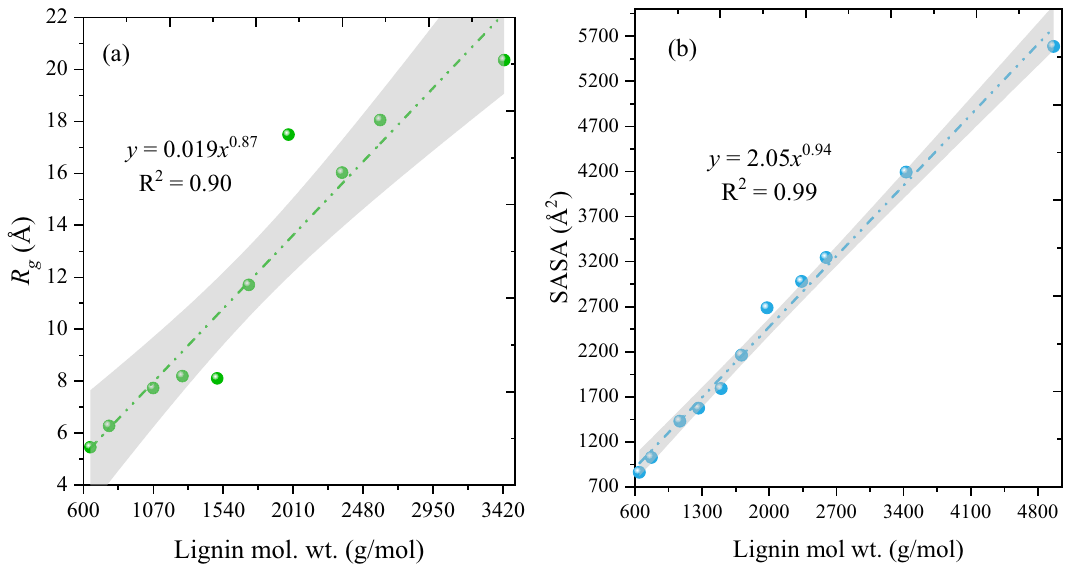
Figure 13. Relationship between ( a ) R g , and ( b ) SASA of lignin and the molecular weight of the lignin